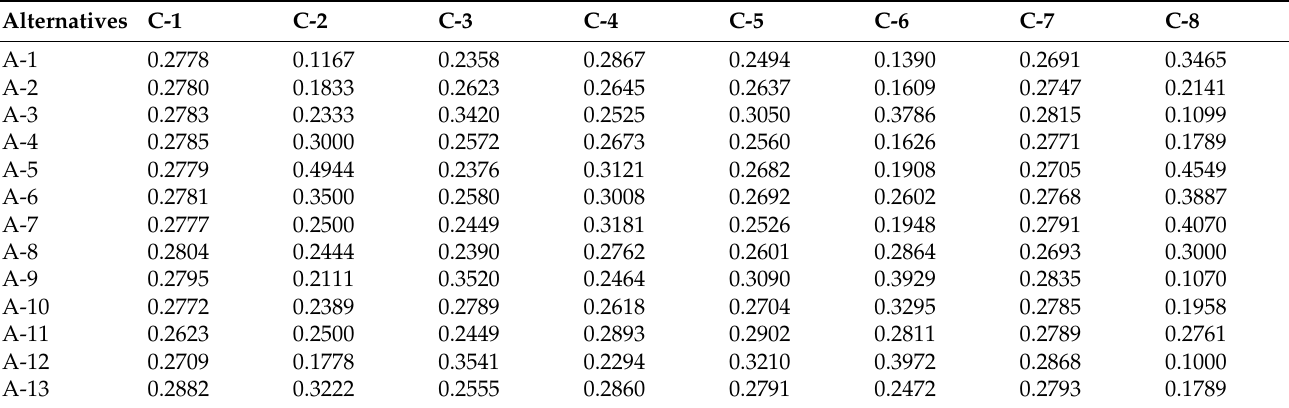
Table 5. Normalized performance matrix.